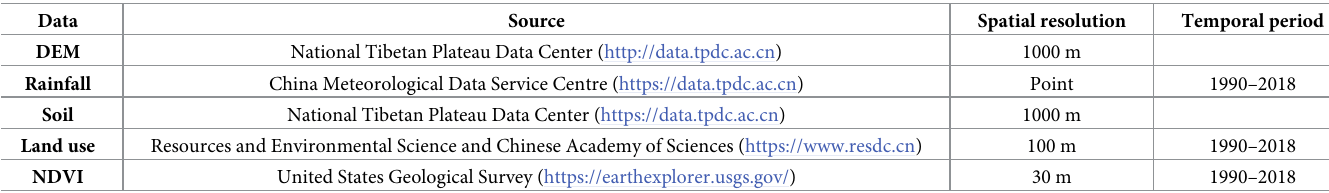
Table 1. Sources of datasets used in this